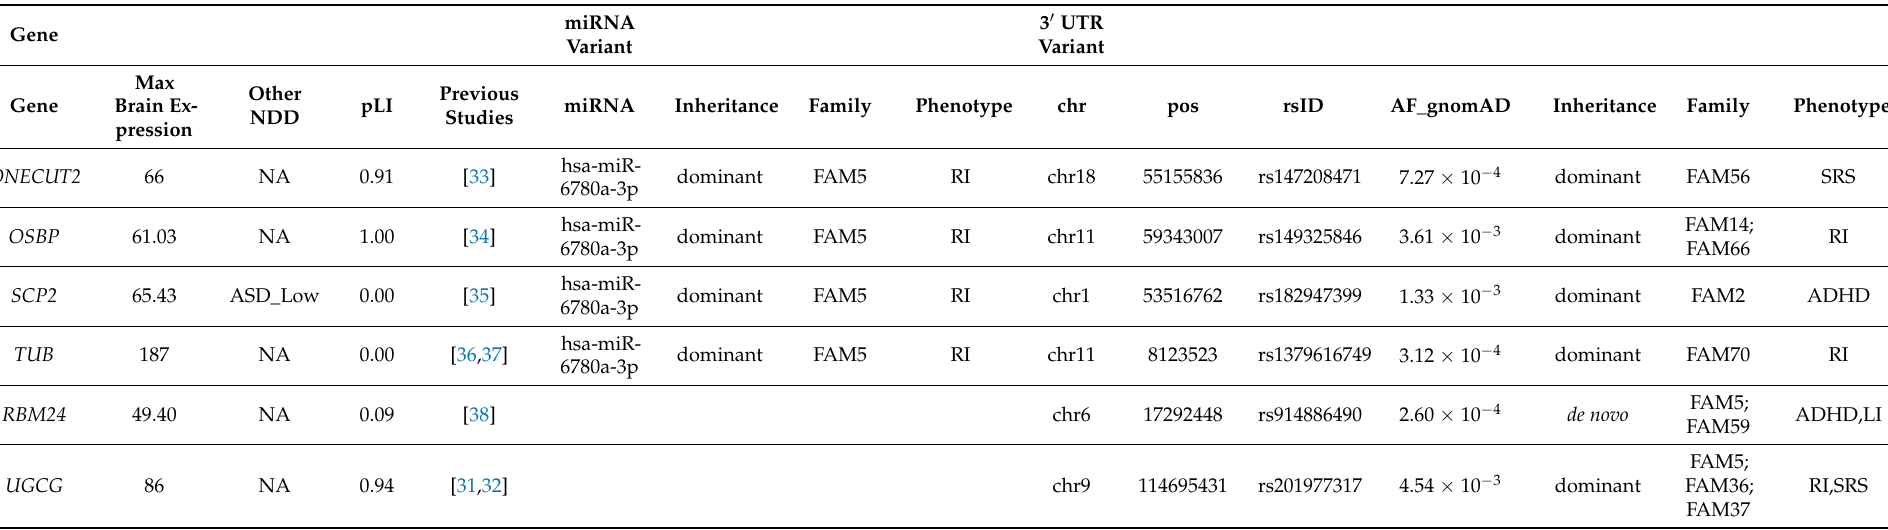
Table 4. Top Candidate